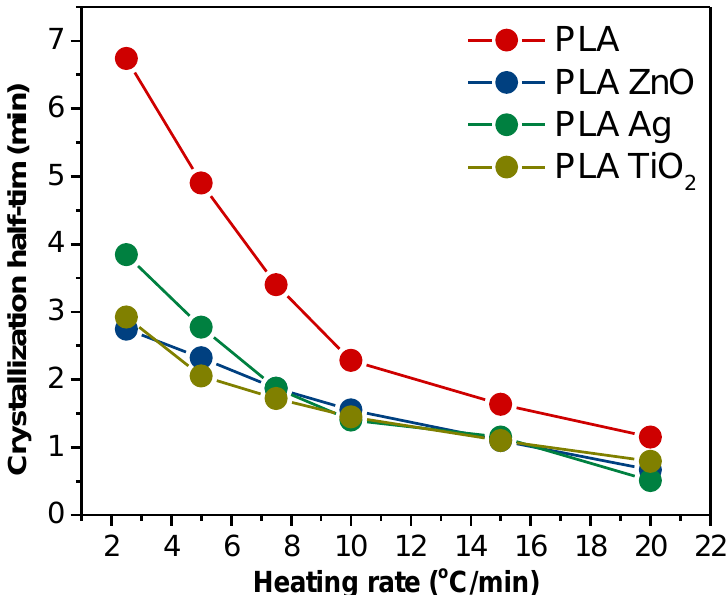
Figure 2. Effect of filler and heating rate on the crystallization half-time of poly(lactic acid) (PLA) during non-isothermal cold crystallization.